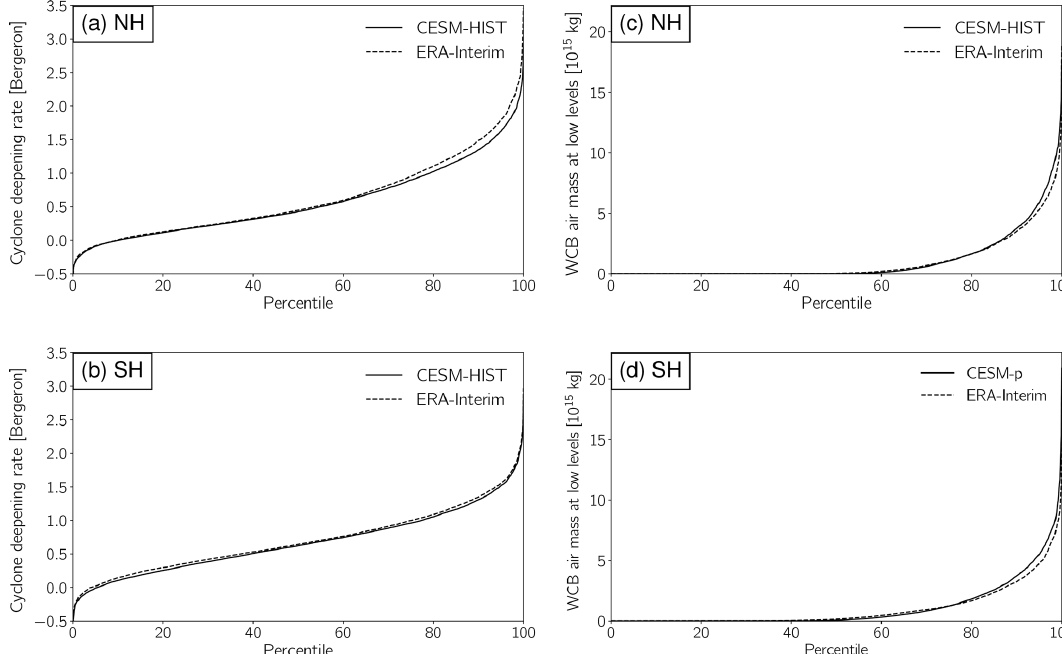
Figure 1. Percentile curves of the (a, b) cyclone-deepening rates (cid:49) SLP B , max (bergeron) and (c, d) WCB strength associated with the cyclones (measured by the WCB air mass at p > 500hPa during the cyclone’s 24h of strongest intensification, in 10 15 kg) for all cyclones in (a, c) NH winter and (b, d) SH winter. The curves are shown in solid lines for CESM-HIST and dashed lines for